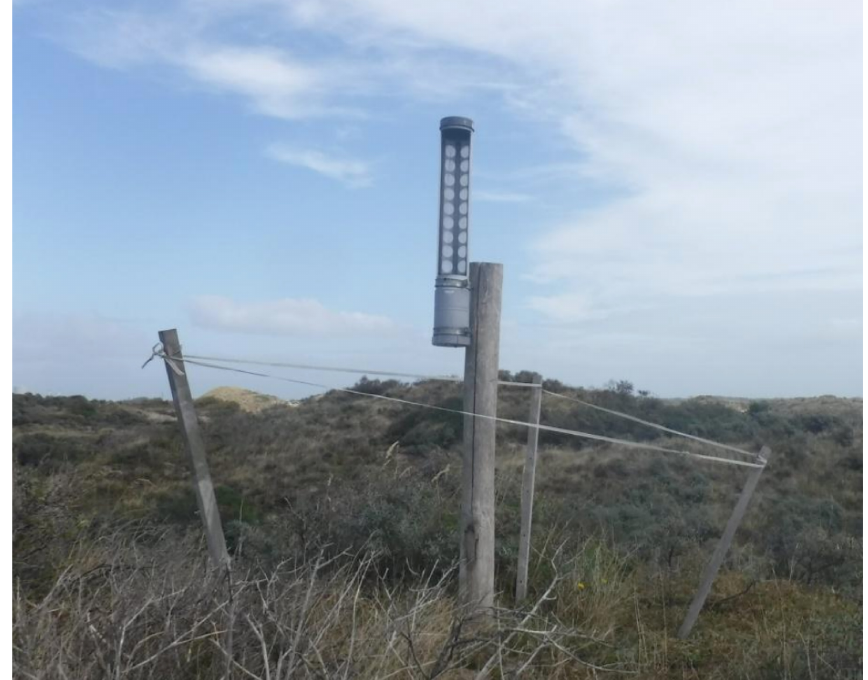
Figure A1. Sediment trap on a vegetated dune.